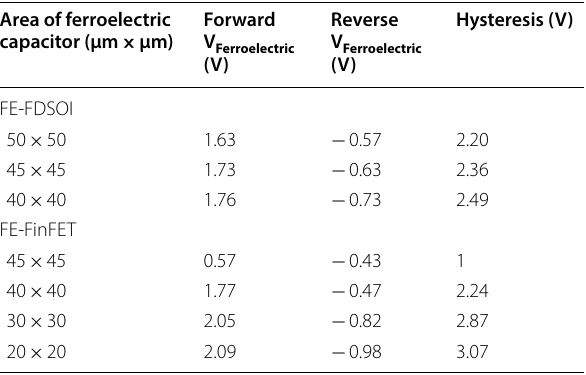
Table 1 The area of ferroelectric capacitor vs. hysteresis of FE-FDSOI/FE-FinFET